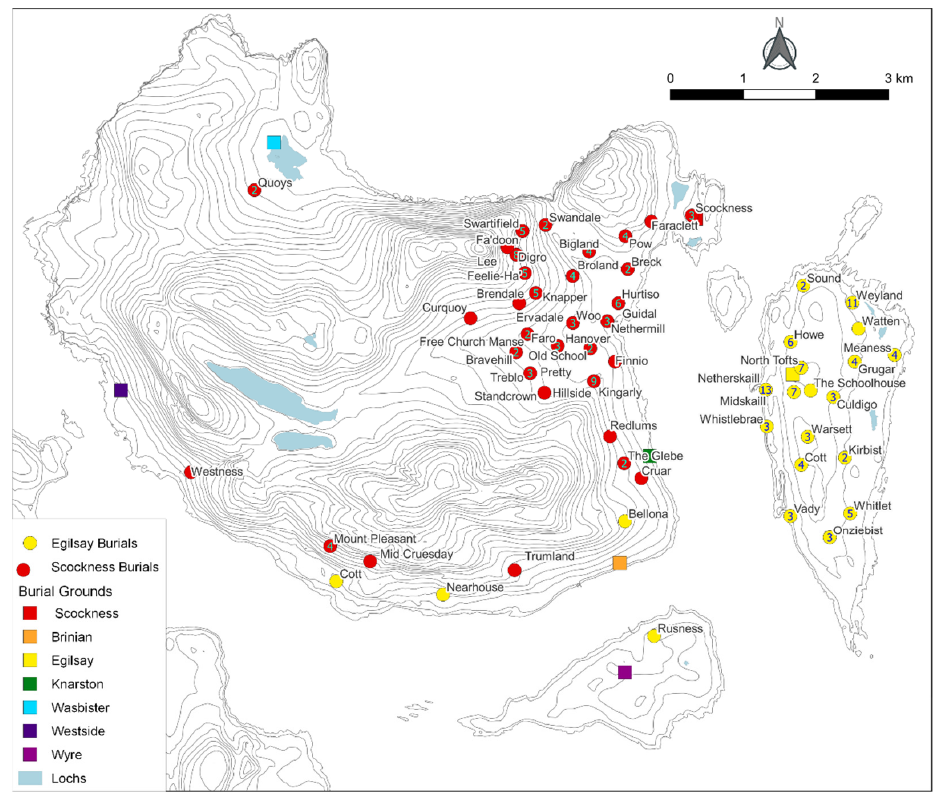
Figure 5. Distribution of the individuals memorialised in the Egilsay and Scockness burial grounds. This represents approximately 74% of the individuals recorded in the two burial grounds, with the remaining people either located outwith the parishes (11%) or unable to determine a residence (15%) (see Table 2 for more detail). OS Mastermap © Crown copyright and database rights 2021 Ordnance Survey (100025252).